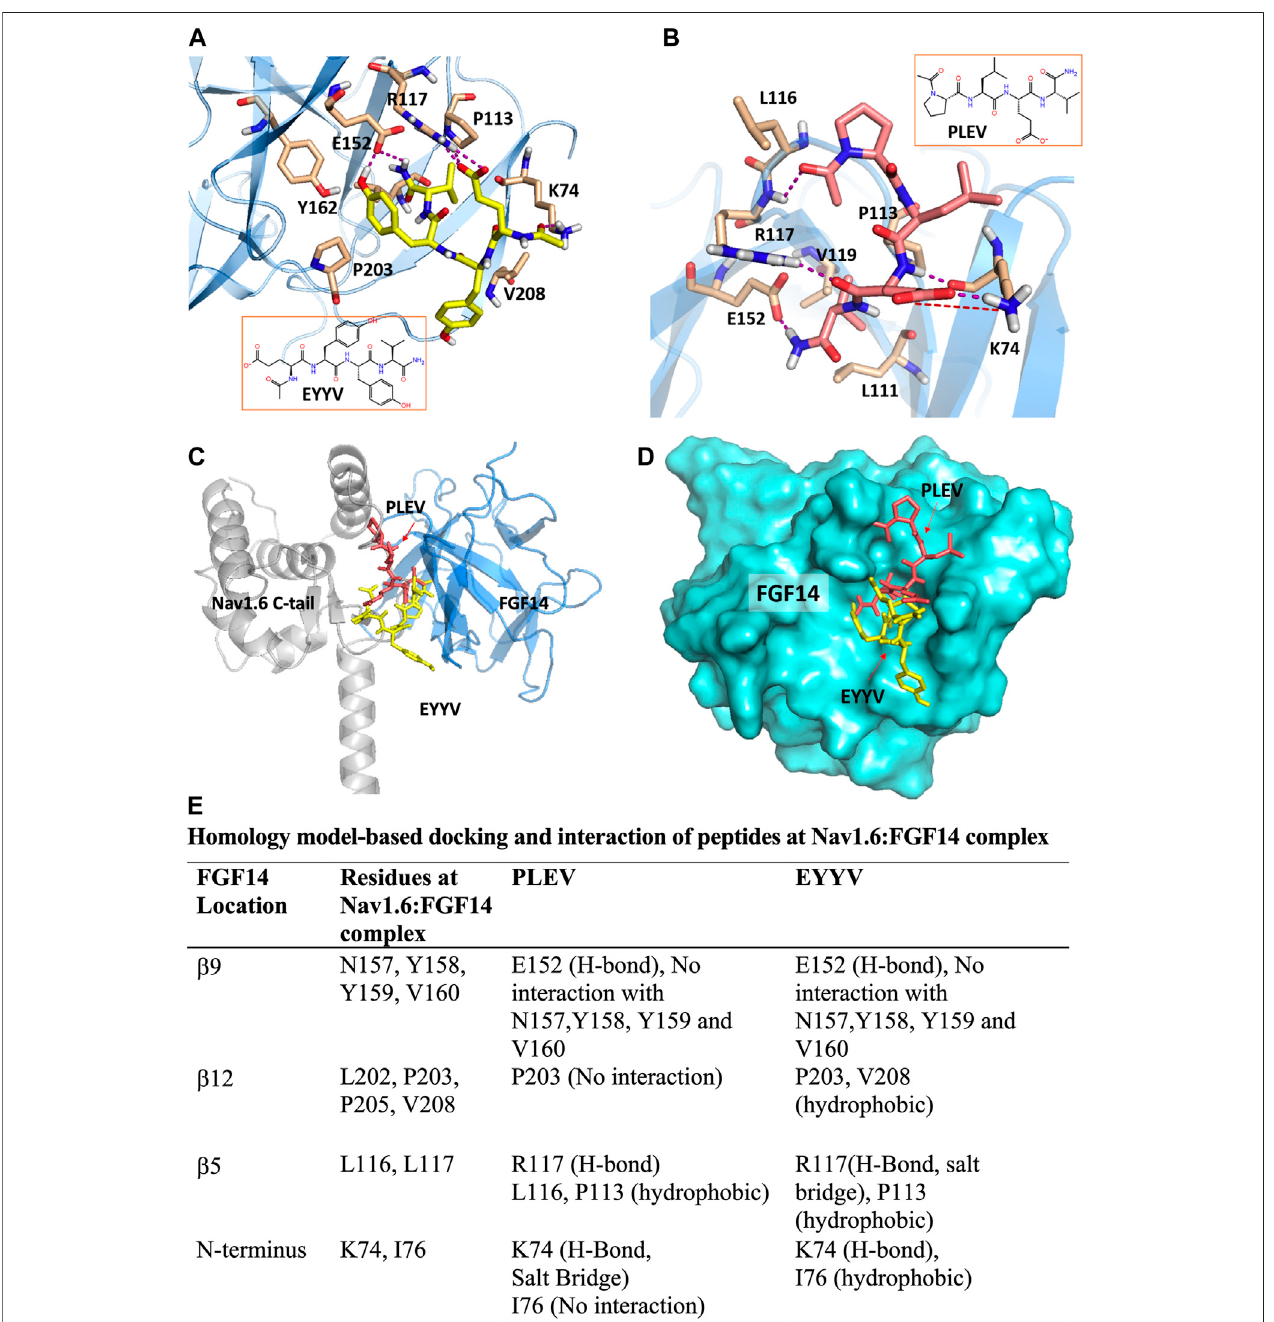
FIGURE 1 | PLEV and EYYV docking to the FGF14:Nav1.6 complex (modi fi ed Singh et al., 2020. Physiol Rep. PMID: 32671946). (A,B) Representation of PLEV (pink-orange) and EYYV (yellow) peptide fragmentsdocked intothe FGF14 chain oftheFGF14:Nav1.6C-terminaltail homology model. FGF14 has depicted asskyblue ribbons. Key interaction residues are highlighted as stick representations. H-bonds are shown as purple dotted lines, salt bridges are shown as red dotted lines. Residues shown in the map are within 4 Å cut-off. (C) Overlay of PLEV (pink-orange) and EYYV (yellow) docked poses and FGF14. Nav1.6 C-terminal tail complex homology model. The FGF14 chain is depicted as sky blue ribbons and the Nav1.6 C-terminal tail is highlighted as gray ribbons. The overlay analysis demonstrated the peptides bound with FGF14 to the different locations at the FGF14:Nav1.6 C-tail protein-protein interaction (PPI) interface. (D) Surface representation of PLEV (pink- orange)andEYYV(yellow)peptidefragmentsdockedposeoverlaywithFGF14(cyan). (E) tablerepresentingtheKeyinteractingresiduesofFGF14:Nav1.6C-terminaltail PPI with PLEV and EYYV.